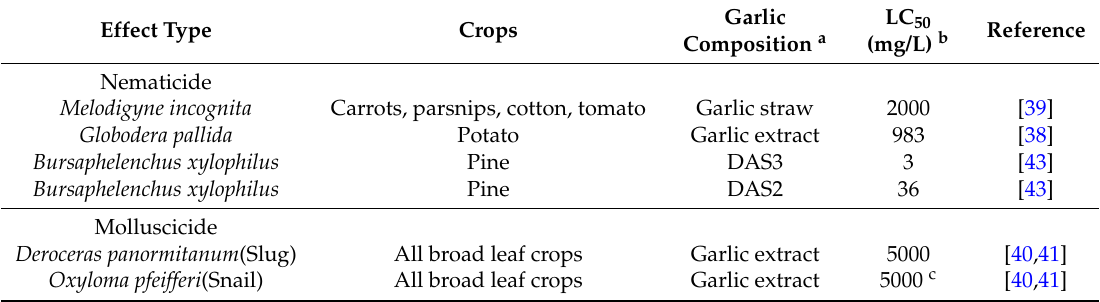
Table 2. Efficacy of different garlic compositions on a range of plant pathogenic nematodes and mollusks.